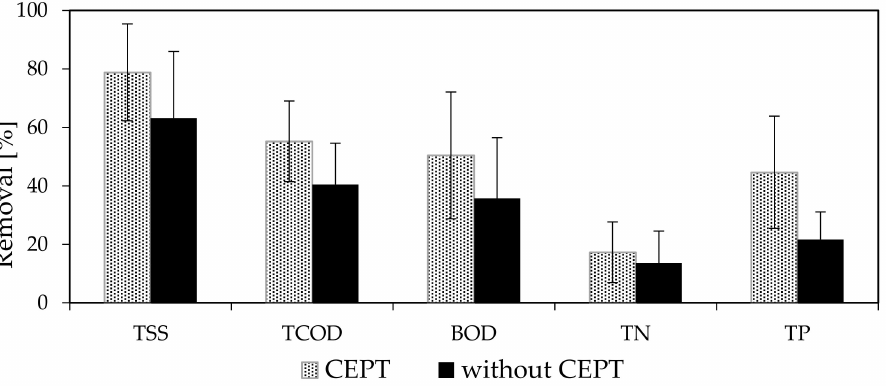
Figure 2. Full-scale trials: removal efficiency of TSS, TCOD, biochemical oxygen demand (BOD), TN, and